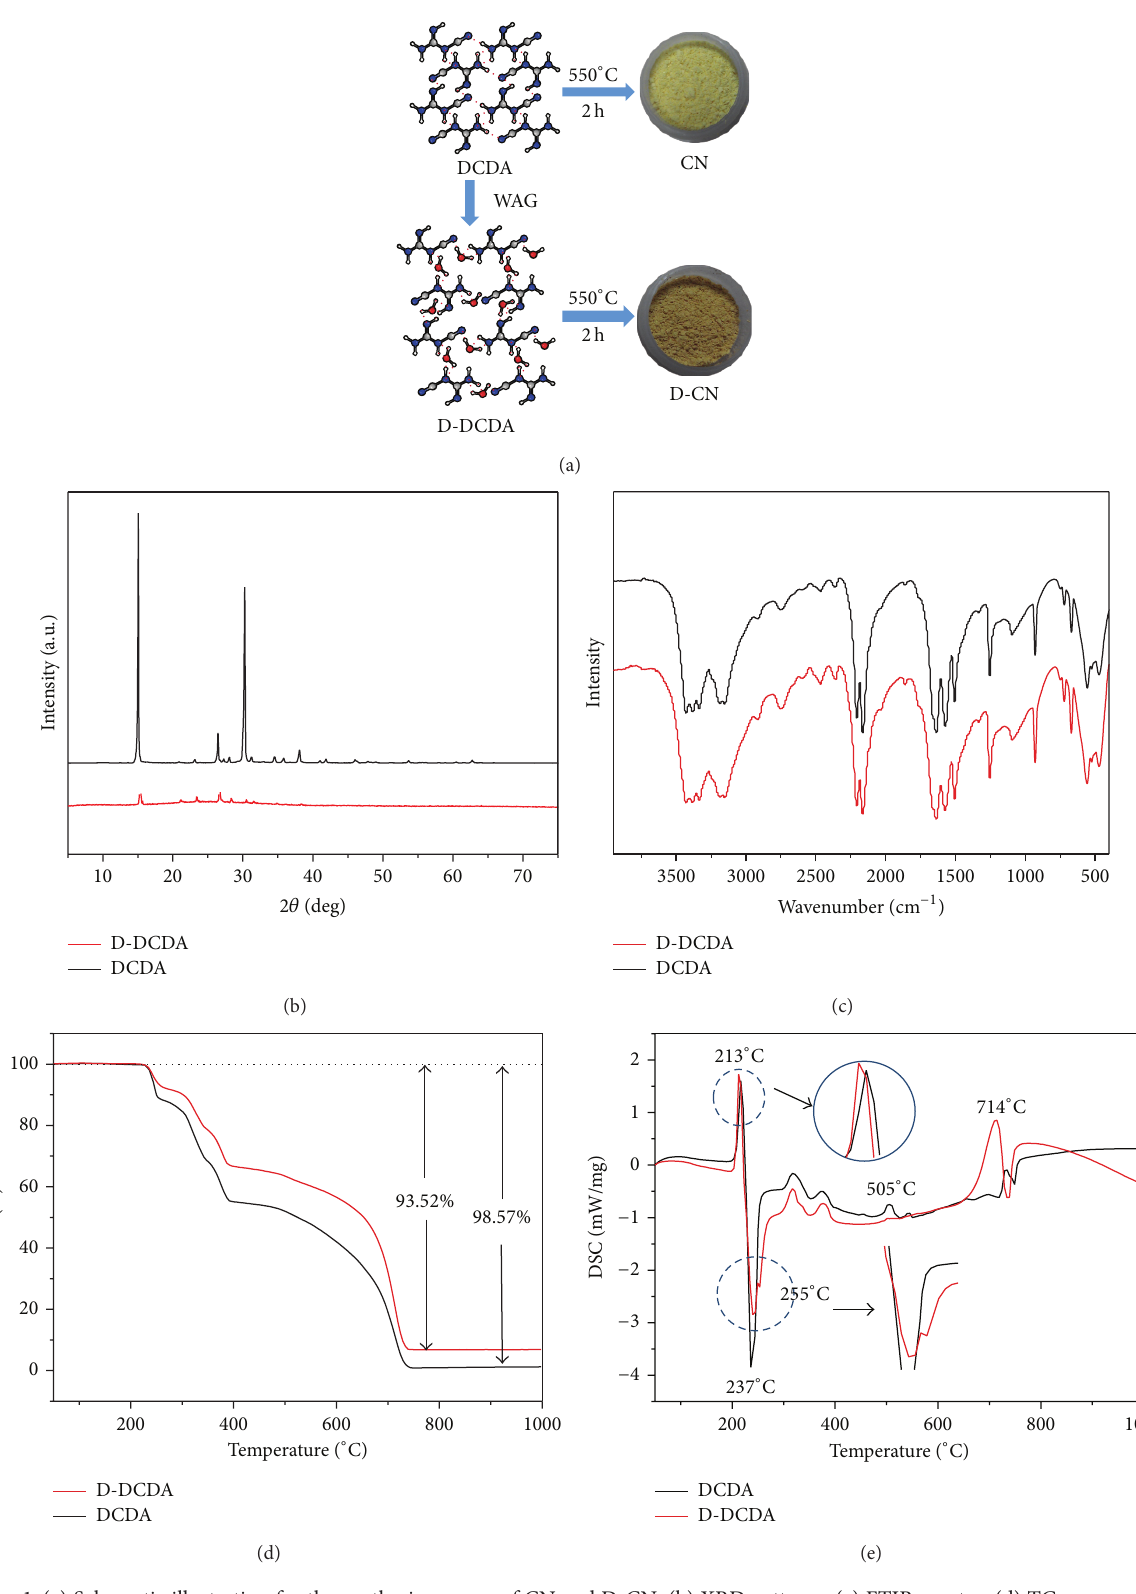
Figure 1: (a) Schematic illustration for the synthesis process of CN and D-CN. (b) XRD patterns, (c) FTIR spectra, (d) TG curves, and (e) DSC curves of the DCDA and D-DCDA